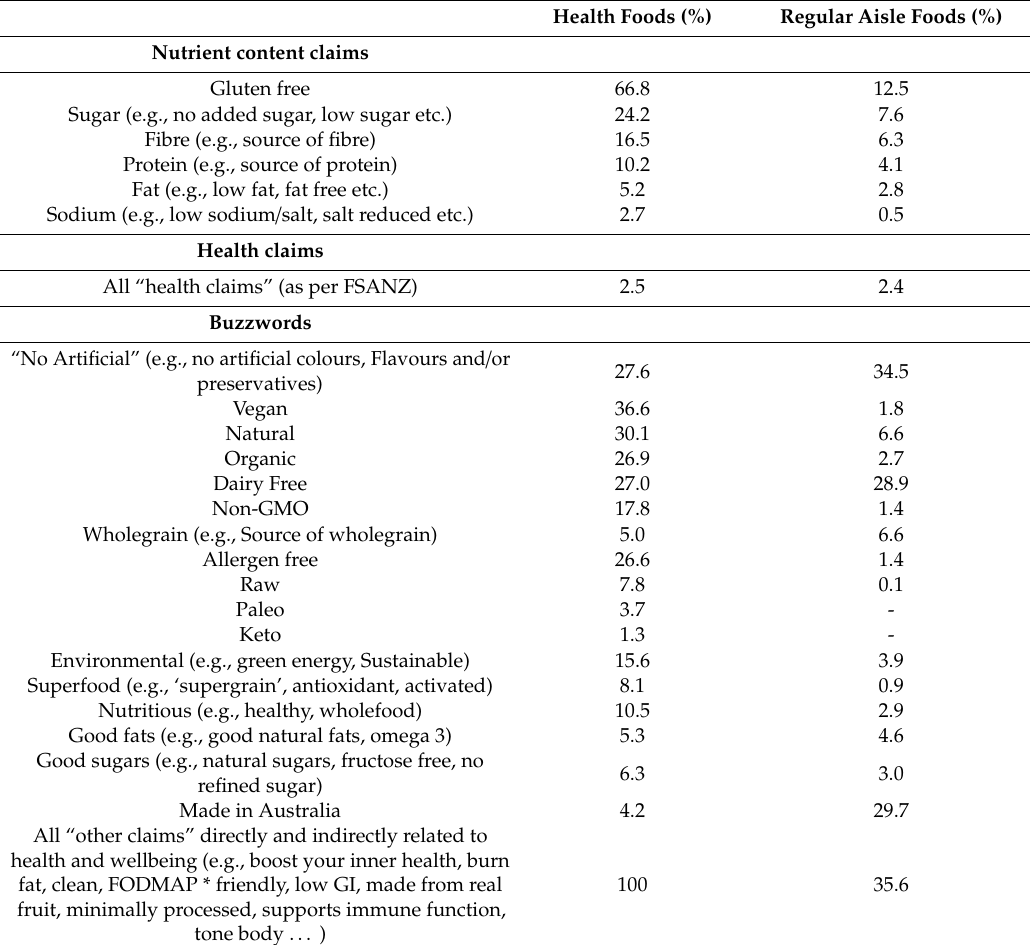
Table 1. The proportion (%) of snack products that display nutrient content claims, health claims or ‘buzzwords’ on health food (HF) snack products sold in supermarkets and specialty HF stores, and equivalent products sold in regular aisles (RA) of supermarkets. FSANZ: Food Standards Australia New